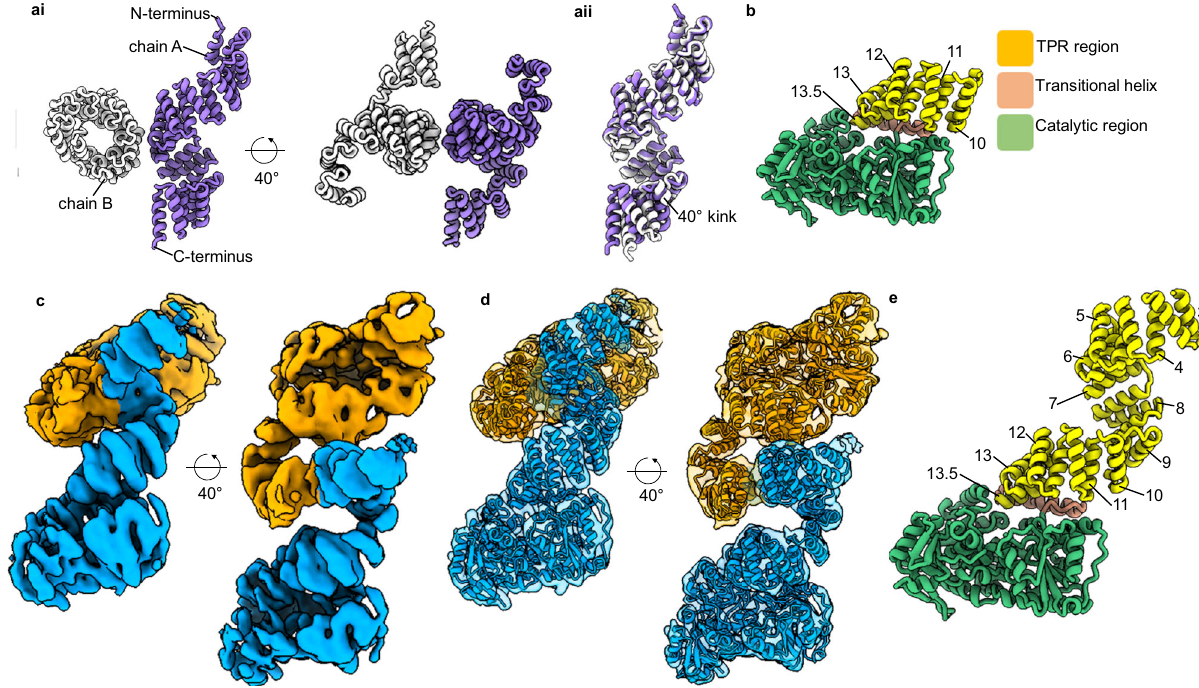
Fig. 1 The structure of unliganded OGT. ai X-ray structure of the dimeric TPRs 11.5 construct 14 . aii Comparison of chain A to chain B demonstrates a 40° kink between chains. b X-ray structure of the catalytic domain of OGT appended to 4.5 TPRs, TPRs numbered 13 . c 5.3 Å cryo-EM map into which the cryo- EM model of the OGT dimer was fi tted ( d ), orange and blue represent separate chains and their associated maps depicted at 40° rotations. e Chain A of the dimer assembly and the TPR units observed are